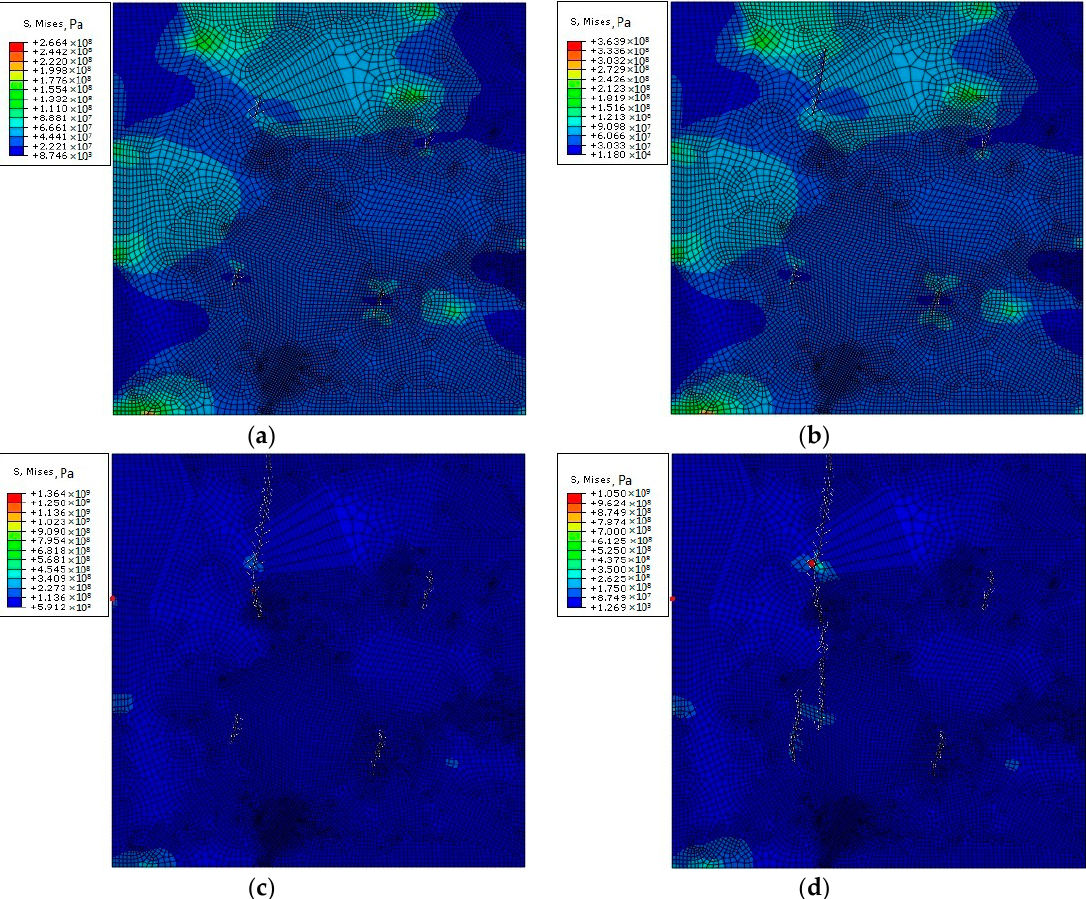
Figure 15. The ( a ) first stage, ( b ) second stage, ( c ) third stage, and ( d ) fourth stage of crack propagation with a load direction of 75°.